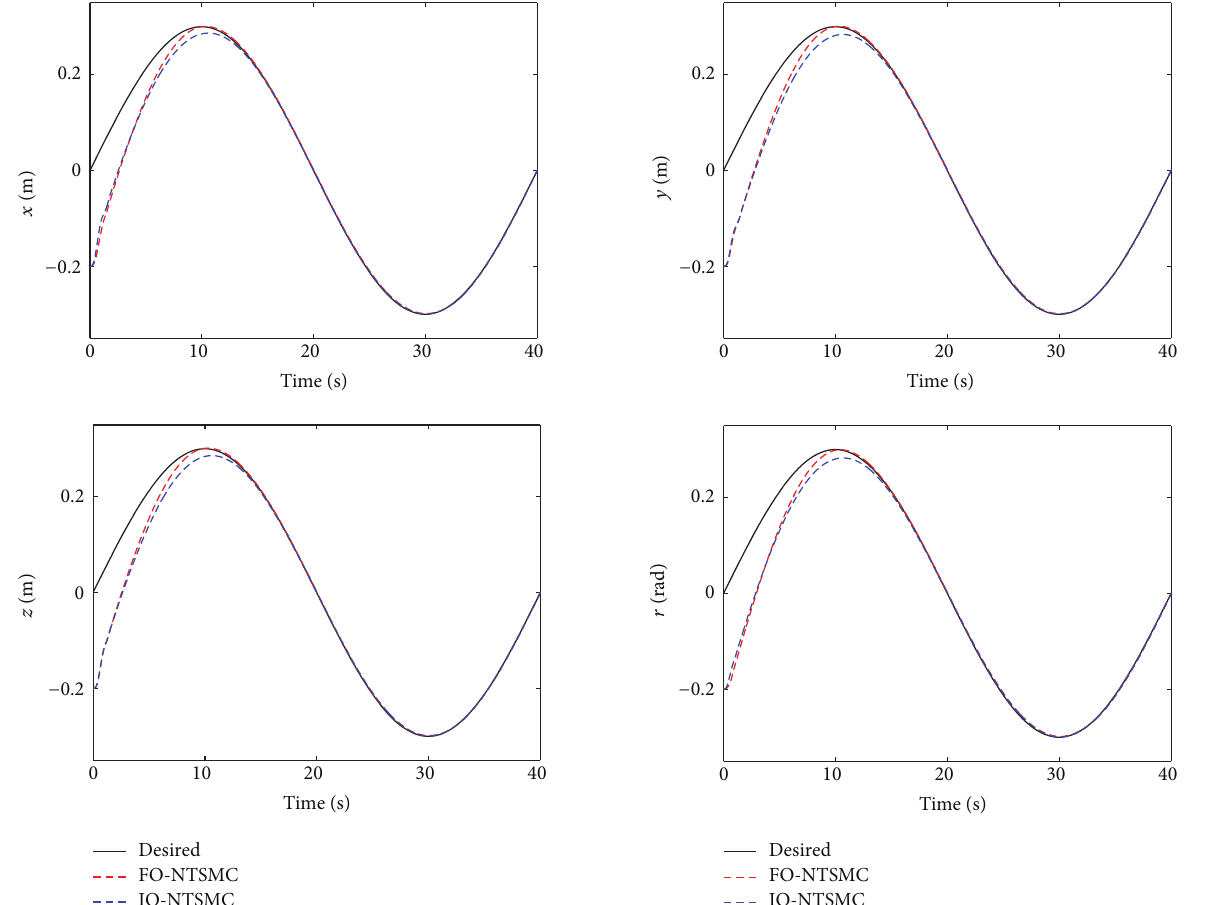
Figure 6: Trajectory tracking performance of output feedback FO-NTSMC and